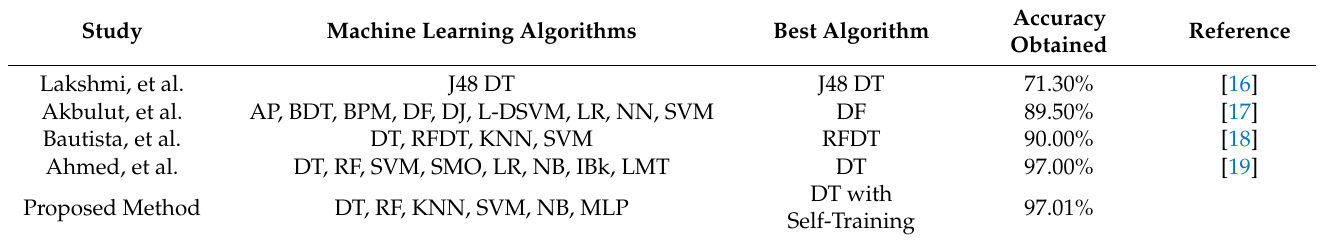
Table 1. The comparison of related studies conducted for the prediction of high-risk pregnancies.